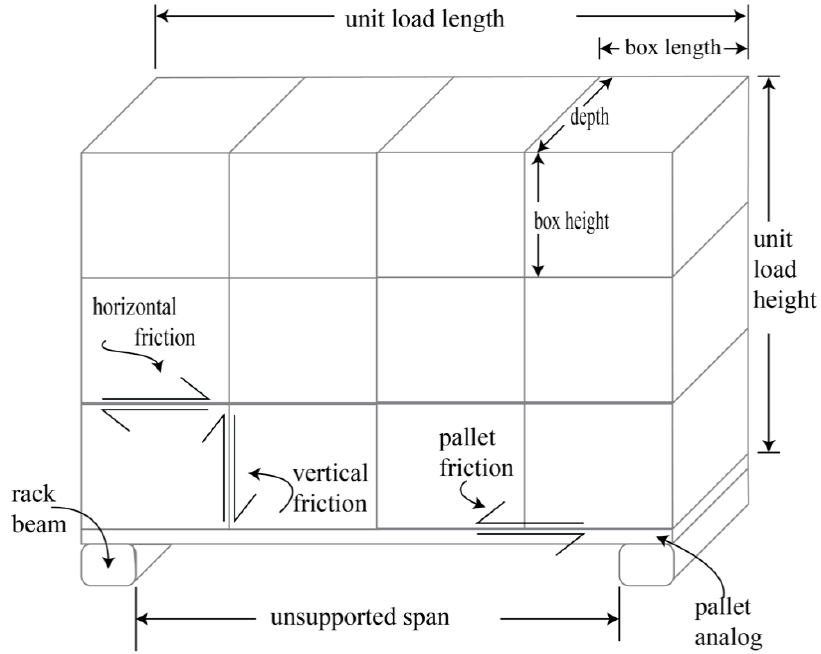
Figure 2. Diagram of the unit load segment and the variables studied [20].